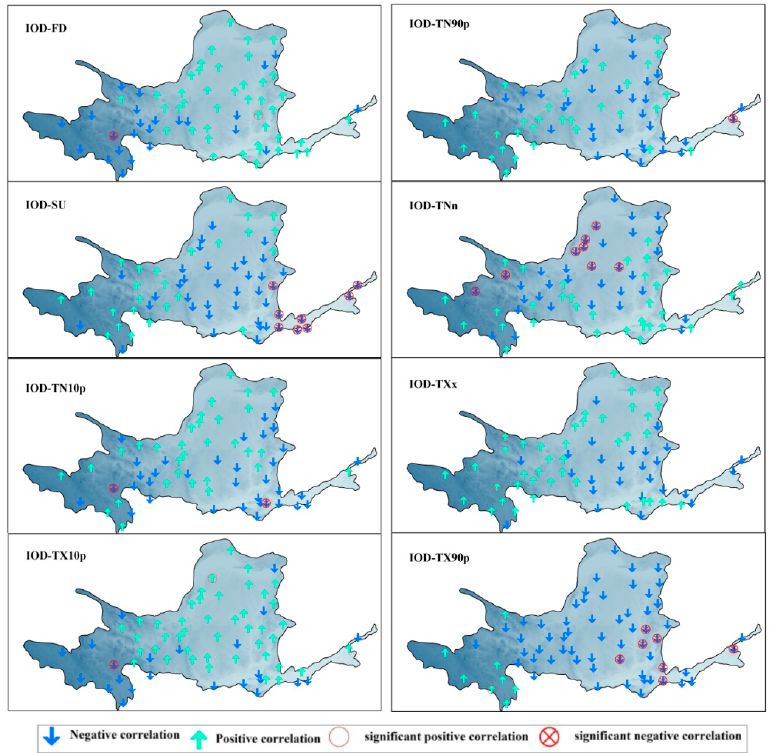
Figure 8. The potential connection between temperature extremes and the Indian Ocean Dipole (IOD).